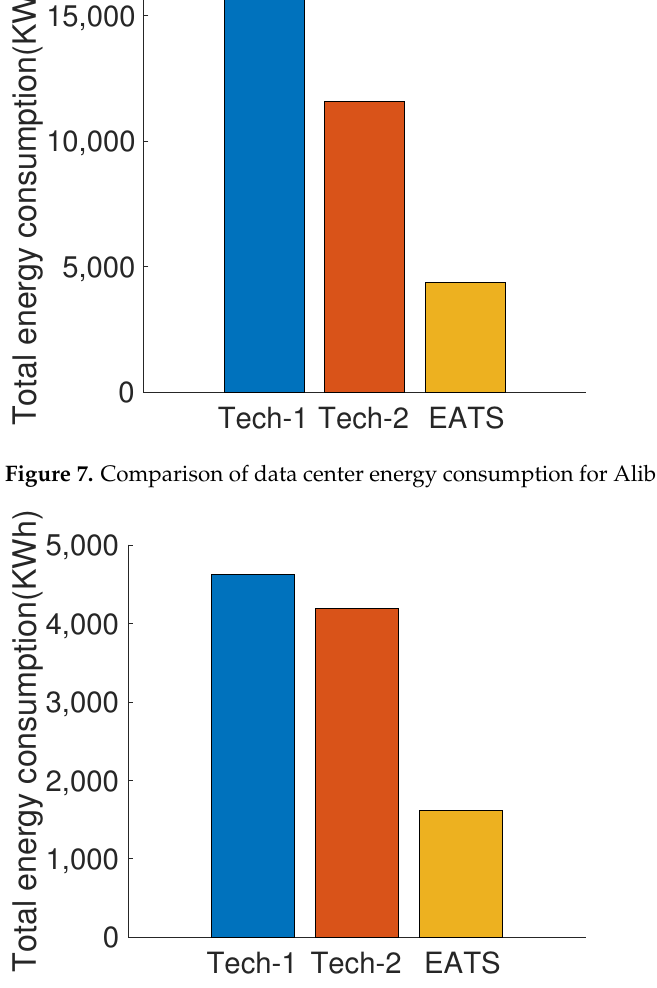
Figure 8. Comparison of data center energy consumption for Google cluster